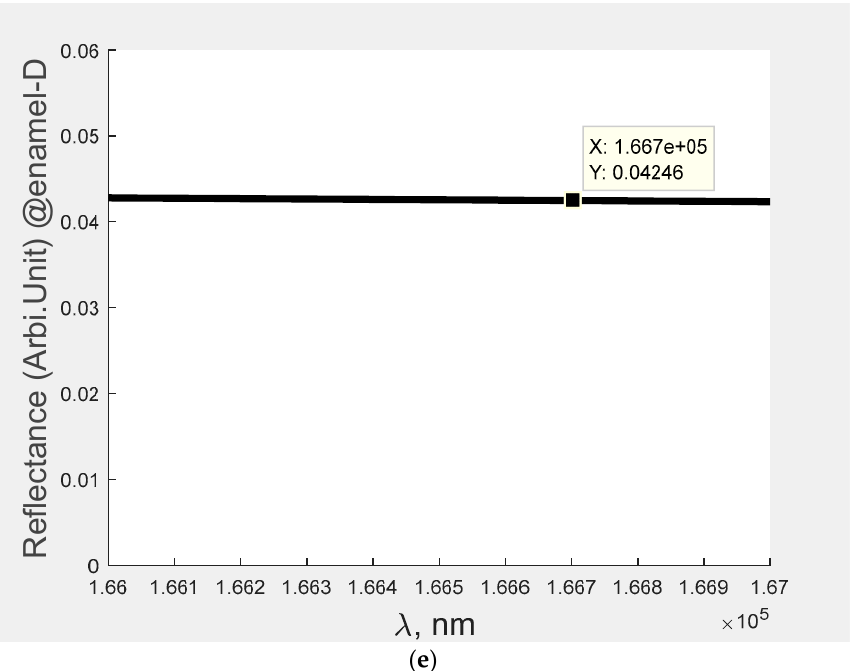
Figure 2. ( a ). Reflectance of enamel normal teeth at the signal 1.8 THz (frequency); ( b ) reflectance of enamel abnormal teeth (A) at the signal 1.8 THz (frequency); ( c ) reflectance of enamel abnormal teeth (B) at the signal 1.8 THz (frequency); ( d ) reflectance of enamel abnormal teeth (C) at the signal 1.8 THz (frequency); and ( e ) reflectance of enamel abnormal teeth (D) at the signal 1.8 THz (frequency).